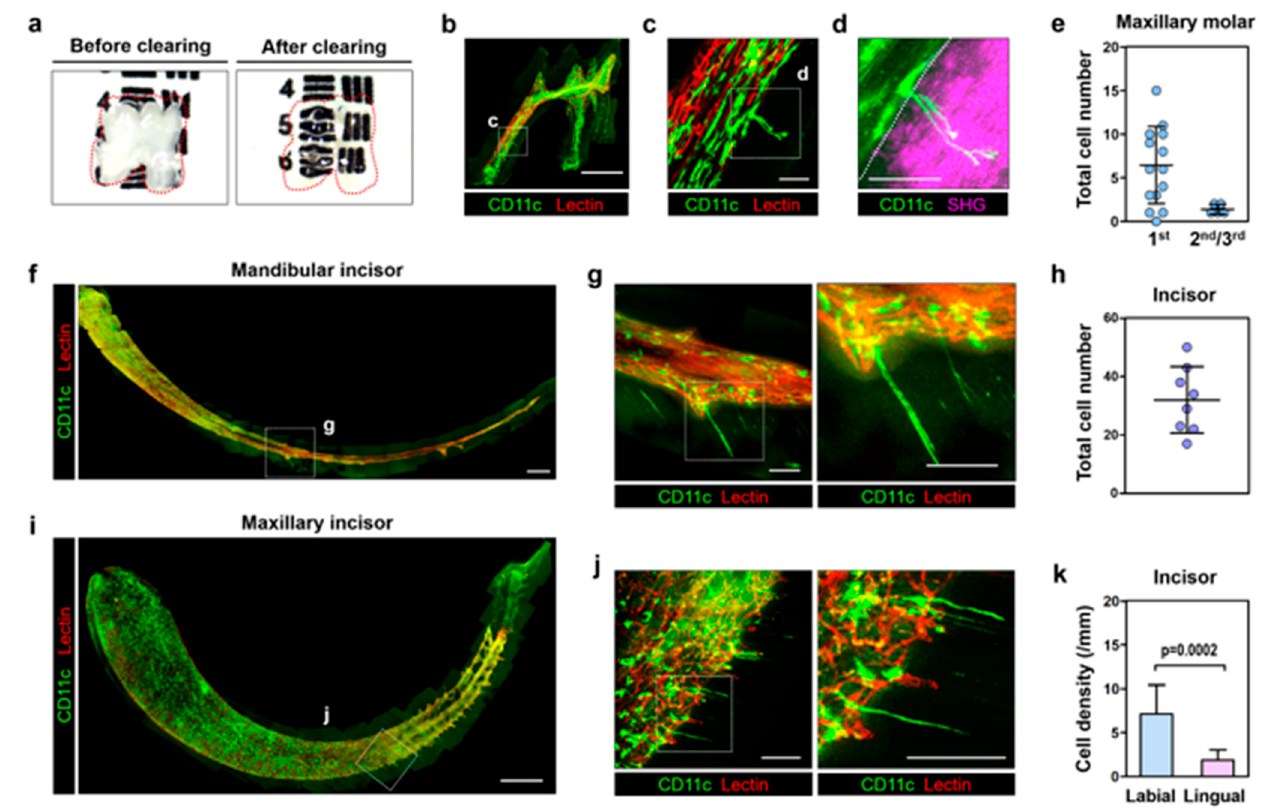
Figure 1. Identification of CD11c+ cells extending cytoplasmic processes into dentinal tubules. ( a ) Photograph 1st of a mandibular molar before and after optical clearing. ( b ) Maximal intensity projection images of 1st maxillary molar extracted from CD11c-YFP mouse showing CD11c-YFP cells (green) and vessels labeled by intravenously injected tomato lectin (red), Scale bar, 500 μ m. ( c ) Magnified image from dotted box in ( b ). Scale bar, 50 μ m. ( d ) Maximal intensity projection image with SHG signal (magenta) of dentinal collagen from dotted box in ( c ). Scale bar, 50 μ m. ( e ) Total cell number of CD11c+ cells at the dentin-pulp interface in maxillary molars (1st maxillary molar; n = 15, 2nd/3rd maxillary molar; n = 6). ( f ) Maximal intensity projection image of mandibular incisor from CD11c-YFP mouse. Scale bar, 500 μ m. ( g ) Magnified images from dotted box in (f). Scale bar, 100 μ m. ( h ) Total cell number of CD11c+ cells at the dentin-pulp interface in incisors ( n = 8). ( i ) Maximal intensity projection image of maxillary incisor from CD11c-YFP mouse. Scale bar, 500 μ m. ( j ) Magnified images from dotted box in (i). Scale bar, 100 μ m. ( k ) Cell density of CD11c+ cells at the dentin-pulp interface in the labial part and lingual part of incisors ( n = 10). Statistical analysis was conducted with paired two-tailed t-tests.